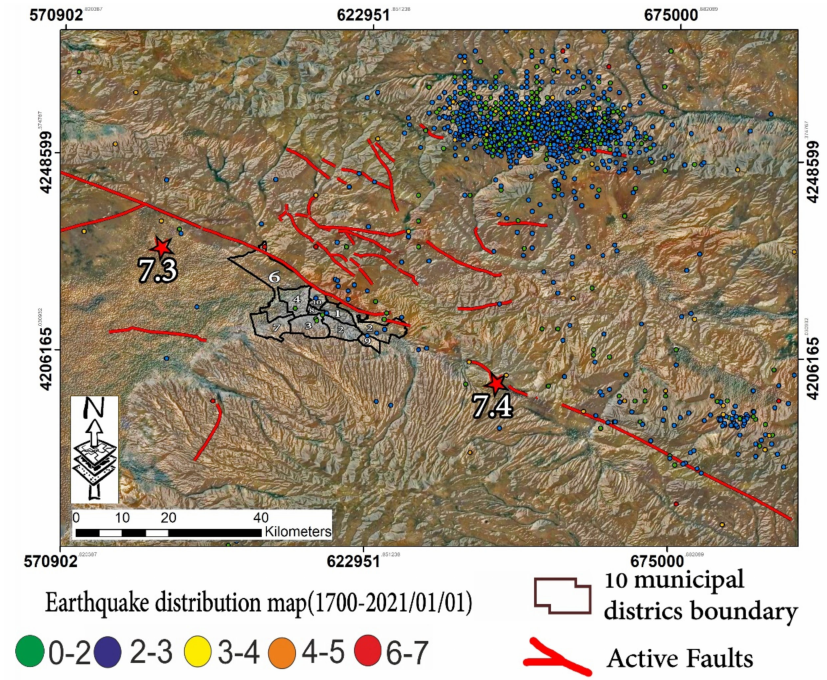
Figure 2. Summarized structural map of Tabriz. The seismicity is based on Berberian 1997, the Centroid Moment Tensor (http://www.globalcmt.org/ accessed on 25 August 2021) and the Inter- national Institute of Earthquake Engineering and Seismology (http://www.iiees.ac.ir accessed on 25 August 2021) catalogs between 1900 and 2012. North Tabriz Fault (NTF), South Misho Fault (SMF), and North Misho Fault